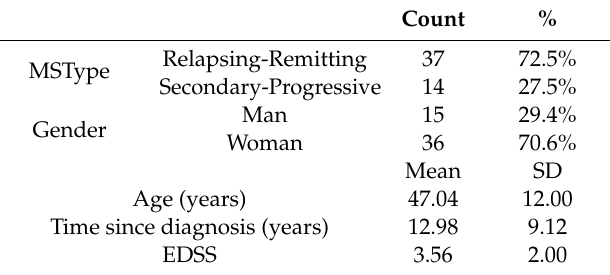
Table 1. Socio-demographic and clinical characteristics of the population of the study.